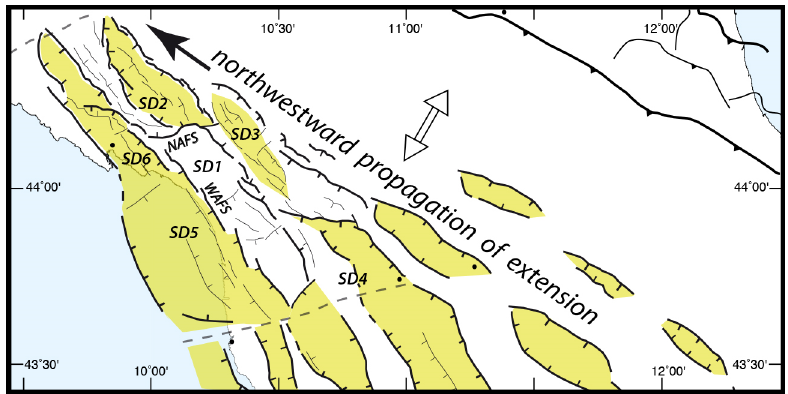
Figure 15. Simplified map of major extensional fault systems in the inner northwest Apennines. Principal grabens are represented, with their sedimentary Plio-Quaternary filling in yellow. The NW–NNW fault systems are suggested to have propagated northwestward in the few last million years. SD: structural domain; NAFS: North Apuane Fault System; WAFS: West Apuane Fault System.